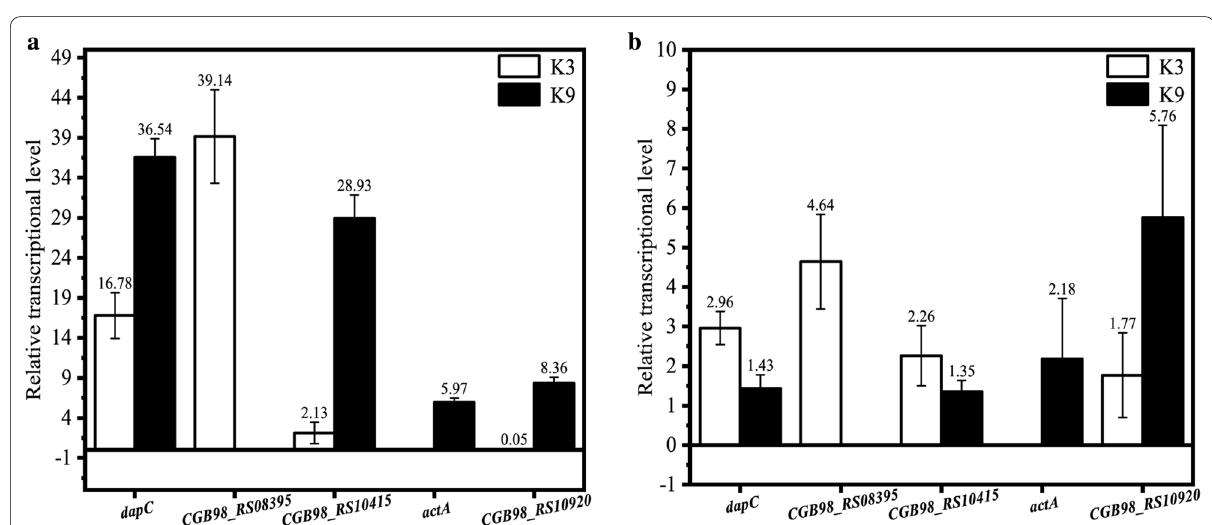
Fig. 6 The relative transcription level of related genes in K3 and K9. a The relative transcription level at 24 h, b The relative transcription level at 48 h. The CGB98_RS08395 of K9 and actA of K3 were not mutated and thereby their transcription levels were not